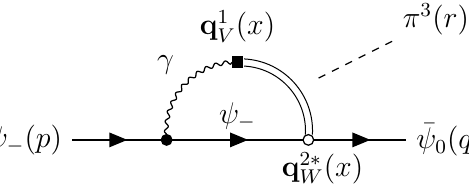
( x ) q 2 ∗ ( x ) . Note that the vertices are provided by the quark current. V W